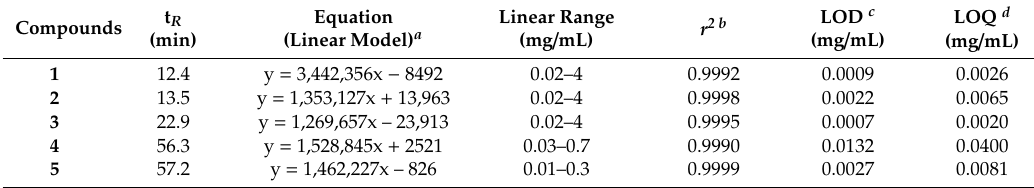
Table 1. Linearity, LOD, and LOQ of the standard compounds.